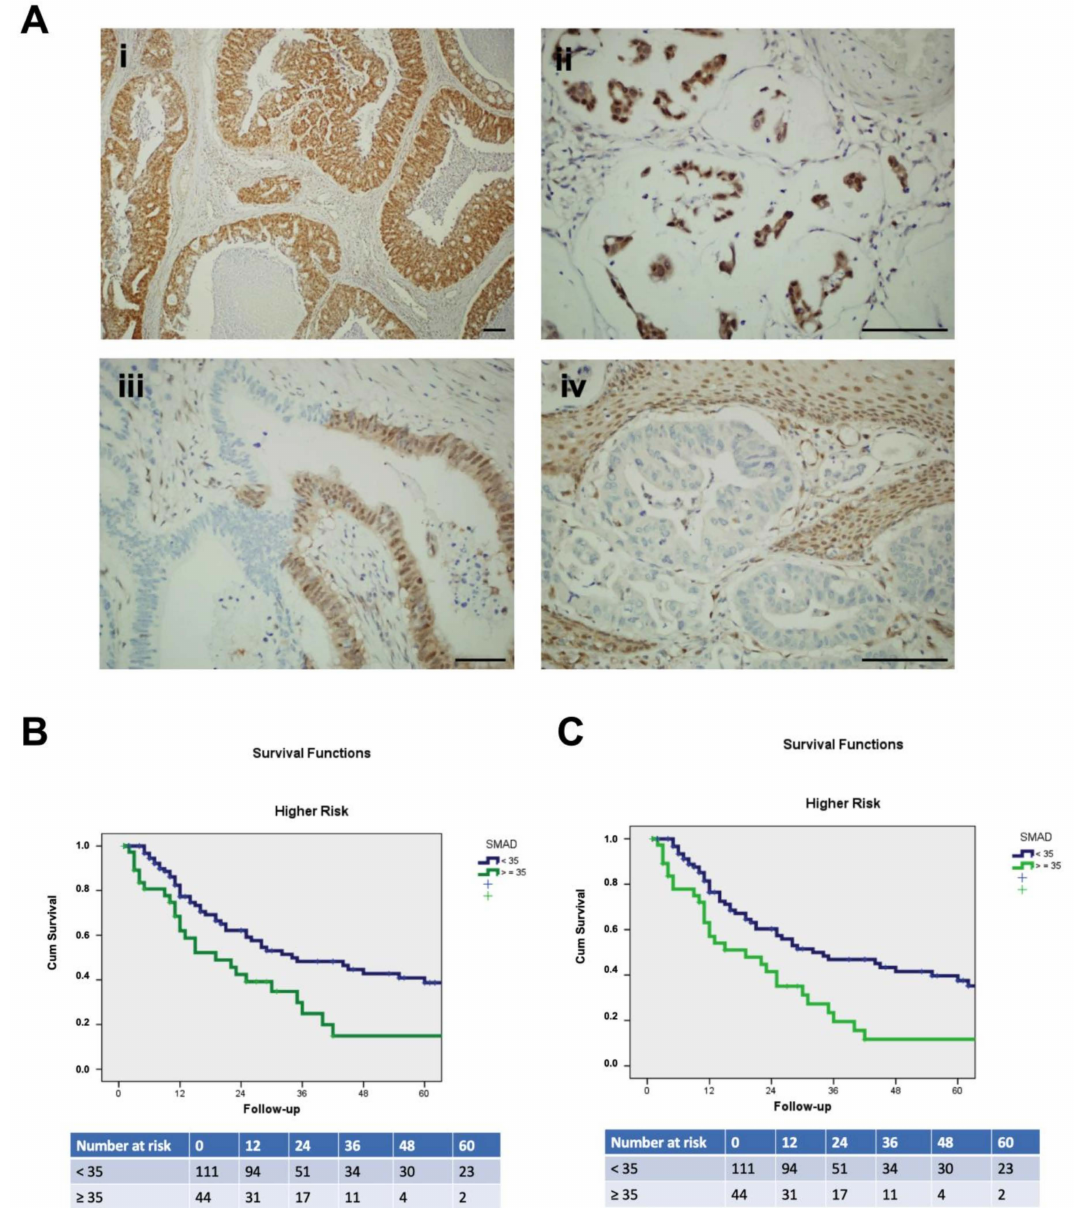
Figure 3. SMAD4 expression patterns and correlation with survival. ( A ) Immunohistochemical patterns observed for SMAD4 expression. Intense preserved SMAD4 immunostain in a sample of differentiated glandular adenocarcinoma ( i ) and in a sample of mucinous muconodular adenocar- cinoma ( ii ). A sample of glandular adenocarcinoma with preserved (right side) and complete loss of SMAD4 expression in the same neoplastic gland ( iii ). Complete loss of SMAD4 in glandular adenocarcinoma with retained expression in the squamous epithelium overlying cancer ( iv ). Scale bar, 100 µ m. ( B ) Cancer-specific survival and ( C ) disease-free survival of EAC cases with loss of SMAD4 staining (in >35% of the neoplastic area) in EACSGE higher risk